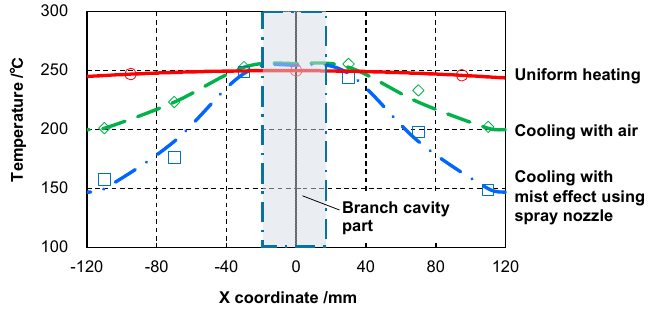
Figure 5. Temperature distributions used in WTHF experiment.